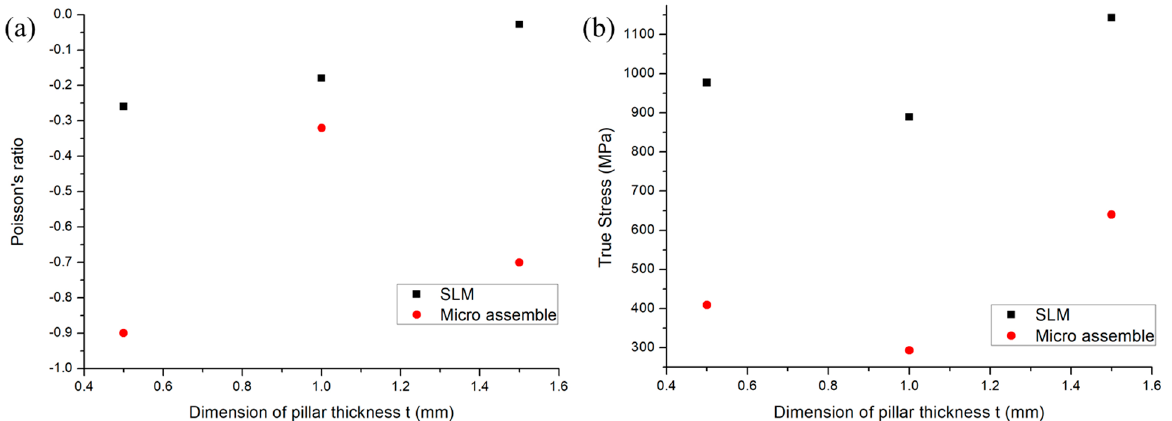
Figure 7. Mechanical properties of SLM and MA 3D auxetic structure: ( a ) Poisson’s ratio ( b ) Young’s Modulus